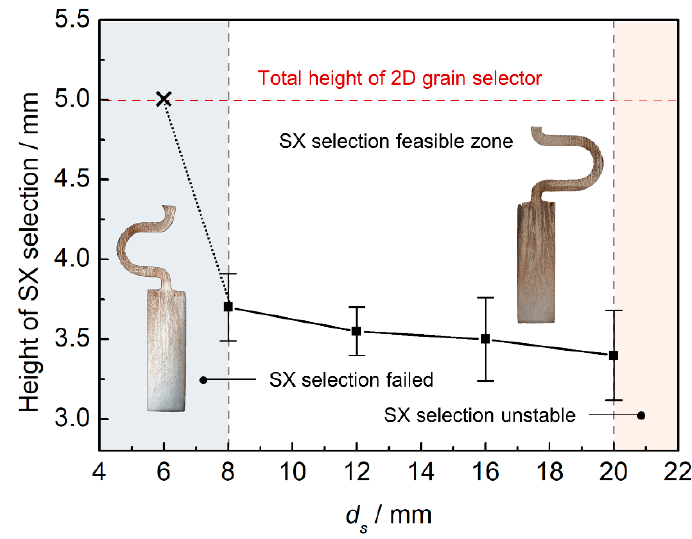
Figure 6. The relationship between heights of SX position and selector eccentric distance ( d s ).